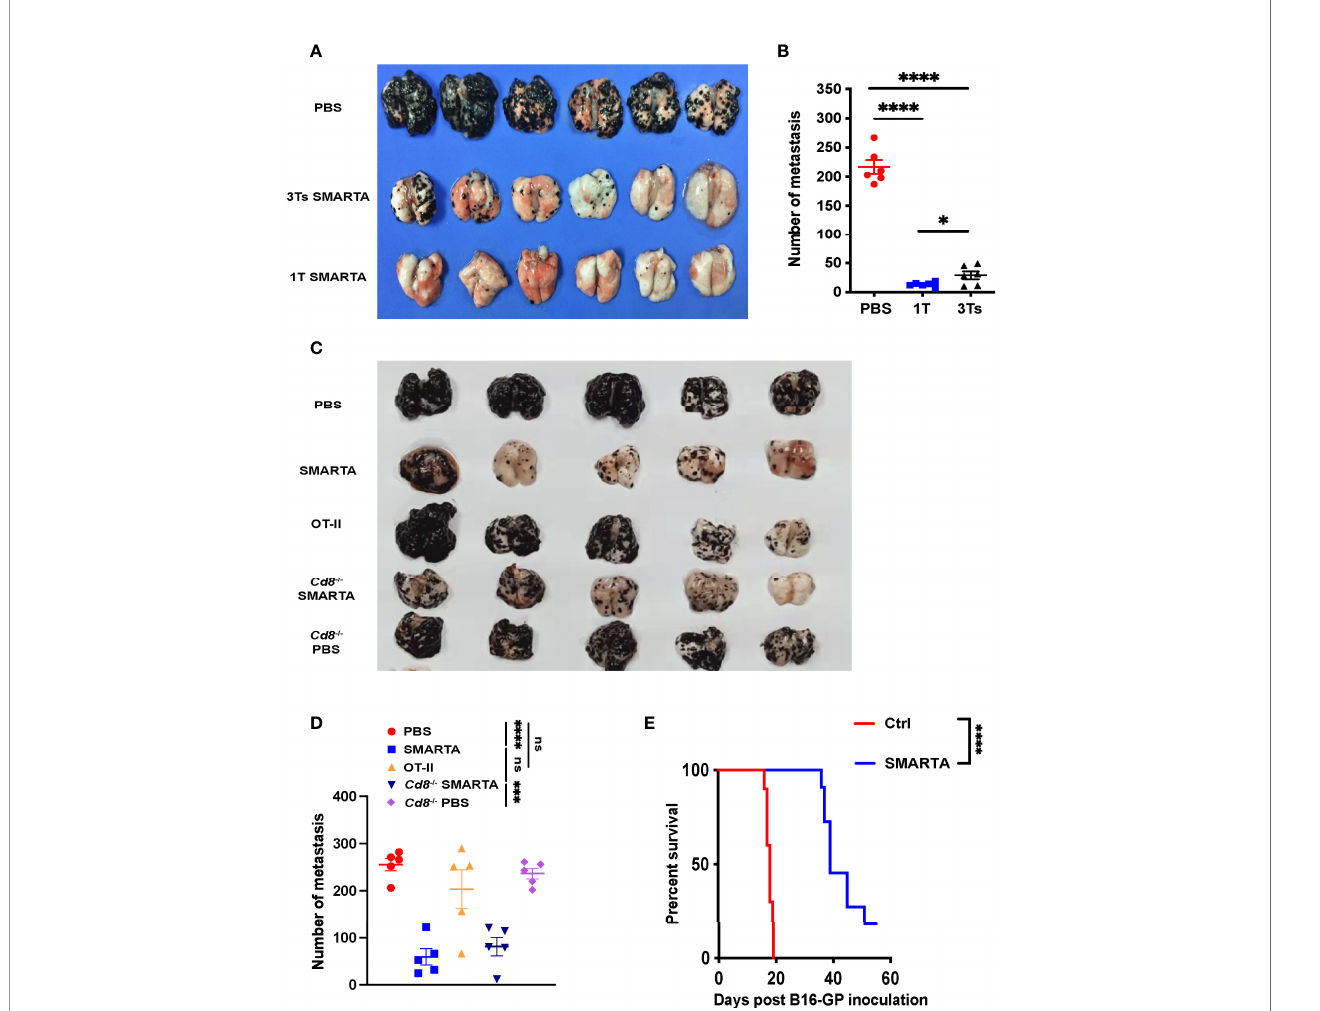
FIGURE 1 | Transfer of tumor-speci fi c CD4 + T cells potently restricts lung metastasis from melanoma. 0.5 × 10 6 B16-GP cells were injected intravenously into C57BL/6J mice (CD45.2 + ) through tail vein to develop the lung metastasis. On Day 7, tumor-bearing mice were administered with CTX (200mg/kg) intraperitoneally and transferred with 2 × 10 6 CD45.1 + activated tumor-speci fi c CD4 + T cells or PBS (control) intravenously 12 hours later (Day 8). (A, B) Image of lung samples harvested from metastasis model in which C57BL/6J mice (n=6/group) were treated with PBS or 2 × 10 6 SMARTA cells in total (once or in three divided doses for 3 consecutive days) and sacri fi ced seven days post-transfer (A) , with the numbers of metastatic foci calculated (B) . (C, D) Image of lung samples harvested from the lung metastasis model in which the C57BL/6J mice (n=5/group) with established B16-GP lung metastasis were treated with PBS, activated SMARTA or OT-II cells, and B16-GP bearing Cd8 -/- mice (n=5/group) were treated with either activated SMARTA cells or PBS (C) . Mice were sacri fi ced on Day 18 post transfer. The statistical analysis of the numbers of metastatic foci in the lung tissues (D) . (E) Survival curve of tumor-bearing mice (n=10/group) treated with activated SMARTA cells or control PBS. Statistical differences are calculated by one-way ANOVA ( B , D , number of metastasis) and Log-rank test ( E , survival curve). ns, not signi fi cant, * p < 0.05, *** p < 0.001, **** p < 0.0001. Data are presented as mean ±